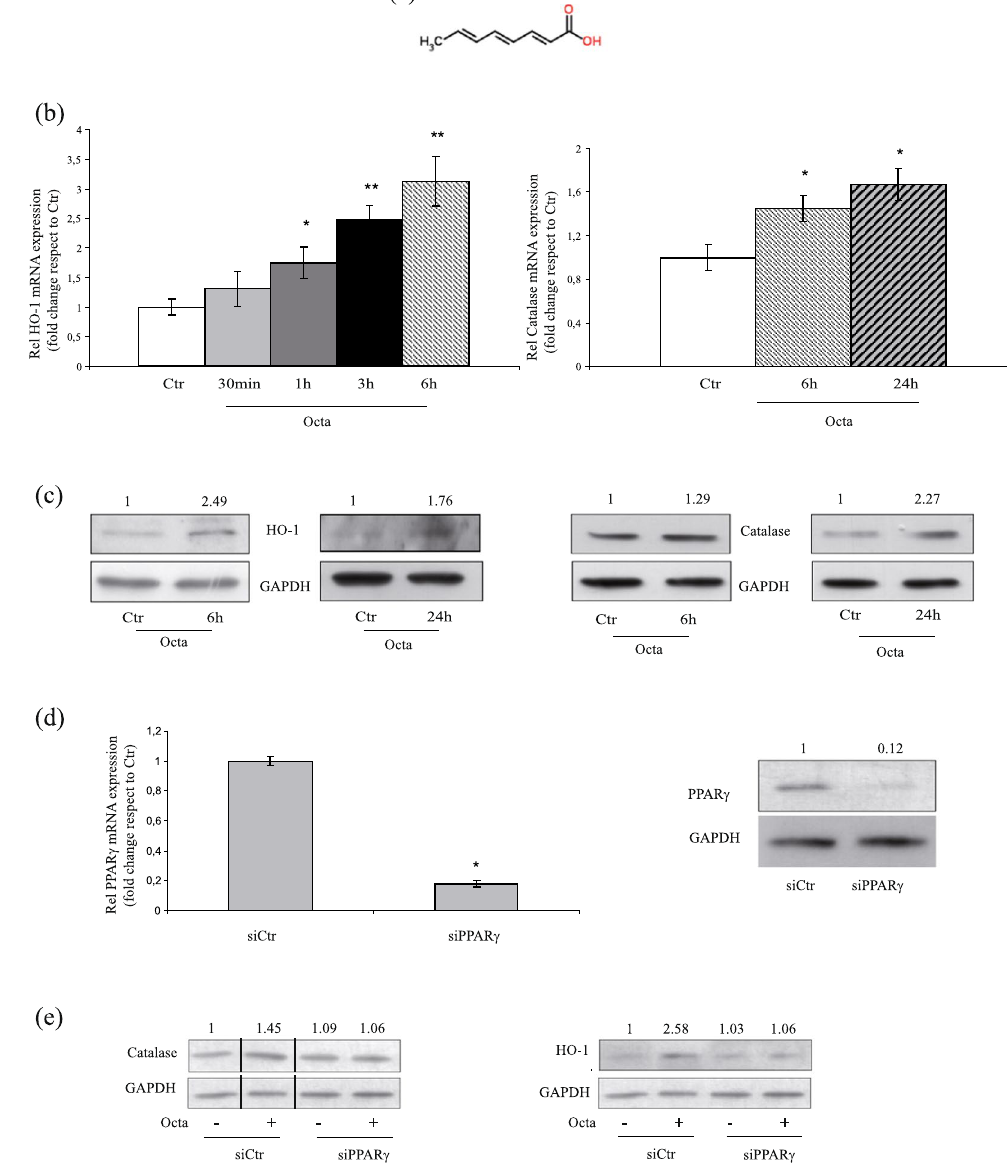
Figure 1. Octa stimulates the cellular antioxidant defense in NHKs through PPAR γ activation. ( a ) Chemical structure of Octa ( b ) Expression of HO-1 and CATALASE mRNA evaluated by quantitative real-time RT-PCR after 30 min, 1, 3, 6 and 24 h of treatment with 90 µ M Octa, respectively. Values are normalized against the expression of glyceraldeide-3-phosphate dehydrogenase ( GAPDH ) and are expressed relative to untreated control cells. The values reported represent means ± SD of three independent experiments performed in triplicate. * p < 0,05, ** p < 0,01 (vs untreated cells) ( c ) Western blot analysis of HO-1 and catalase protein expression on cell lysate of NHKs treated with 90 µ M Octa for 6 and 24 h. GAPDH was used as an equal loading control. Results refer to three independent experiments. Representative blots are shown. Densitometric scanning of band intensities was performed to quantify the change of protein expression (control value taken as one fold in each case). ( d ) NHKs were transfected with siRNA specific for PPAR γ (siPPAR γ ) or non-specific siRNA (siCtr). PPAR γ level was evaluated by real-time RT-PCR (the values reported represent means ± SD of three independent experiments performed in triplicate. * p < 0,001, vs siCtr cells) and Western blot analysis using an anti-PPAR γ antibody. Results refer to three independent experiments. Representative blots are shown. Densitometric scanning of band intensities was performed to quantify the change of protein expression (control value taken as one fold). ( e ) Western blot analysis of HO-1 and catalase protein expression after 24 h exposure to 90 µ M Octa in NHKs transfected with siPPAR γ and siCtr. GAPDH was used as a loading control. Results refer to three independent experiments. Representative blots are shown. Densitometric scanning of band intensities was performed to quantify the change of protein expression (control value taken as one fold in each